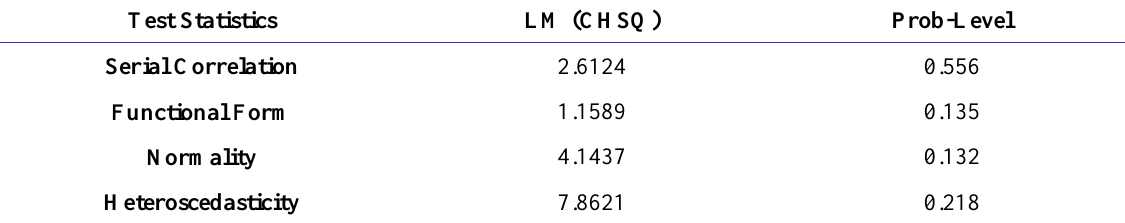
Table 6. Results of diagnostic